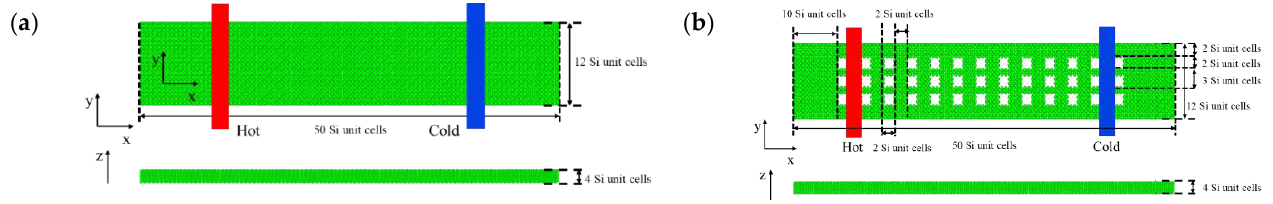
Figure 2. The thermal conductivity calculation model: ( a ) crystalline film; ( b ) porous structure film.